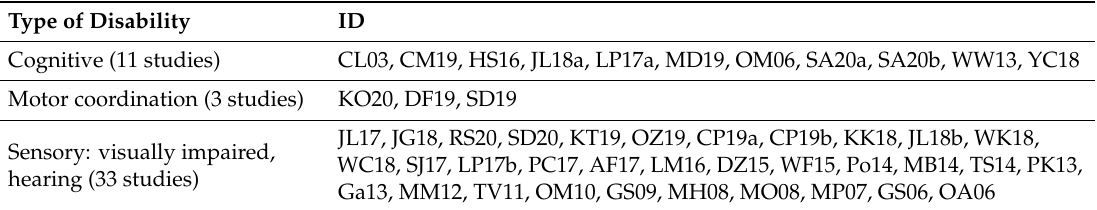
Table 5. Studies by disability.